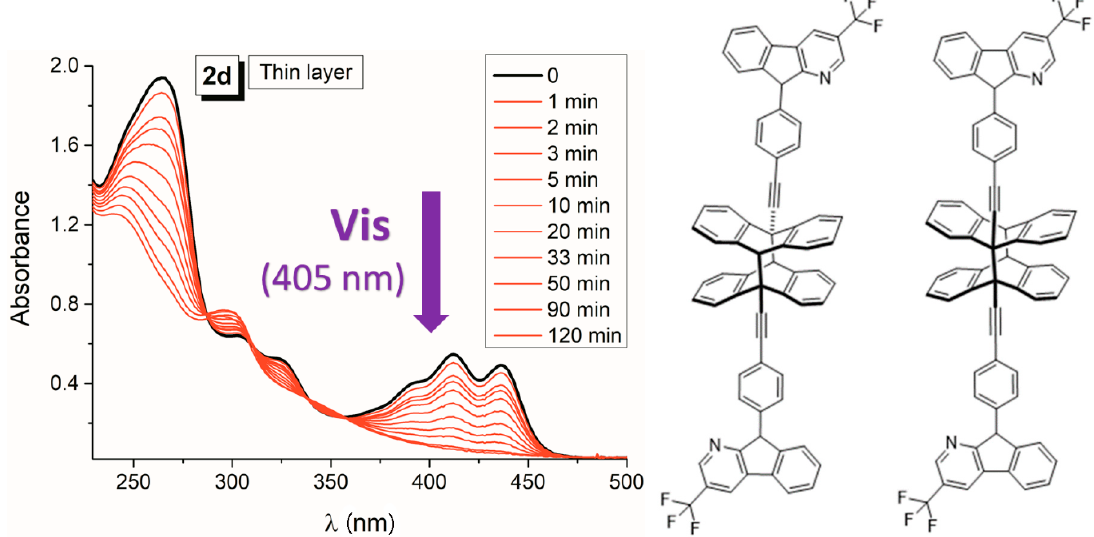
Figure 4. Evolution of the absorption spectrum of carboline 2e in the thin solid film layer on the quartz substrate during its irradiation with Vis light of a 405-nm wavelength (four epoxy-encased LED diodes; LED405E from Thorlabs) ( left ) and the proposed structure of the anthracene dimer due to photochemically-allowed [4 π s + 4 π s ] dimerization through anthracene subunits during the 2e thin solid film irradiation with Vis light ( λ irr = 405 nm) ( right